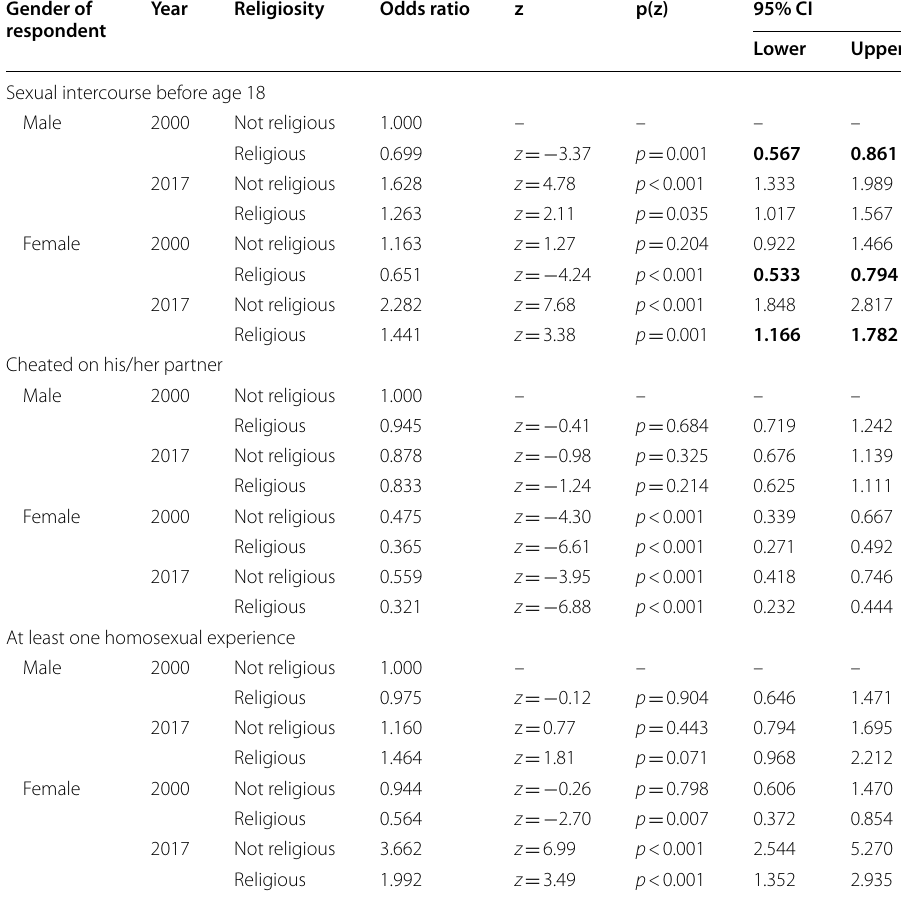
Table 7 Behaviors (Respondent had...). Odds ratio, z, p(z), and 95% confidence intervals by gender and year of interview of logistic